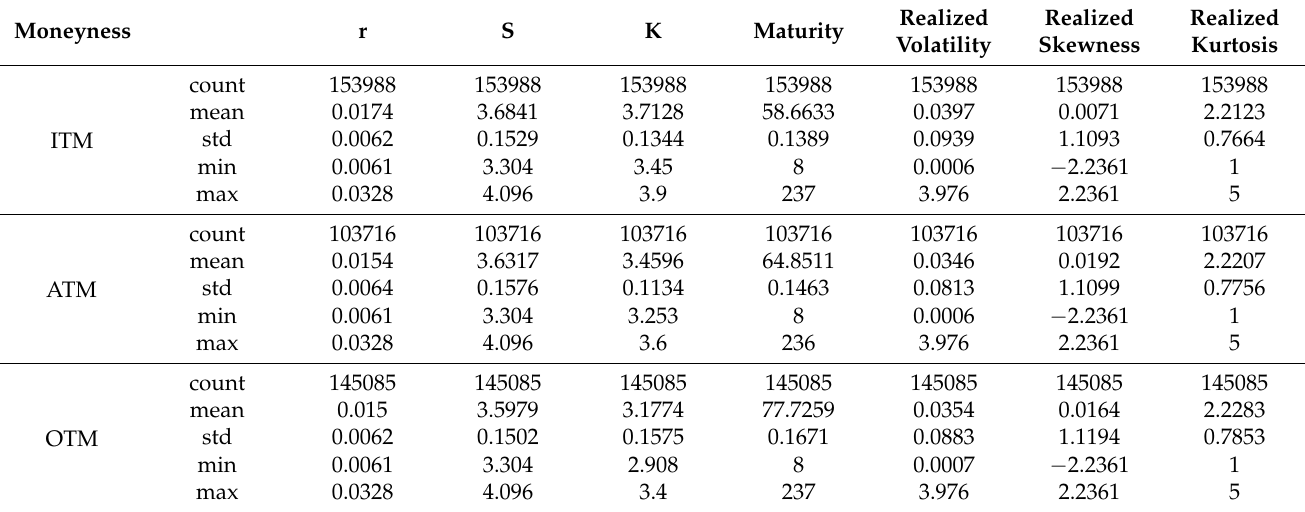
Table 4. Statistics of ETF50 Put options sorted by